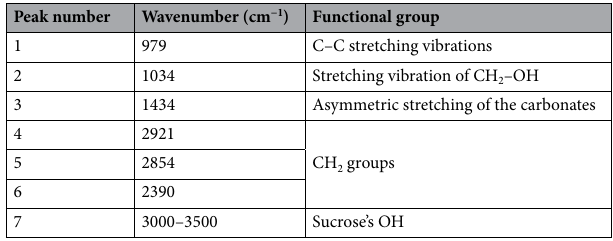
Table 1. FT-IR peaks assigned to different functional groups.